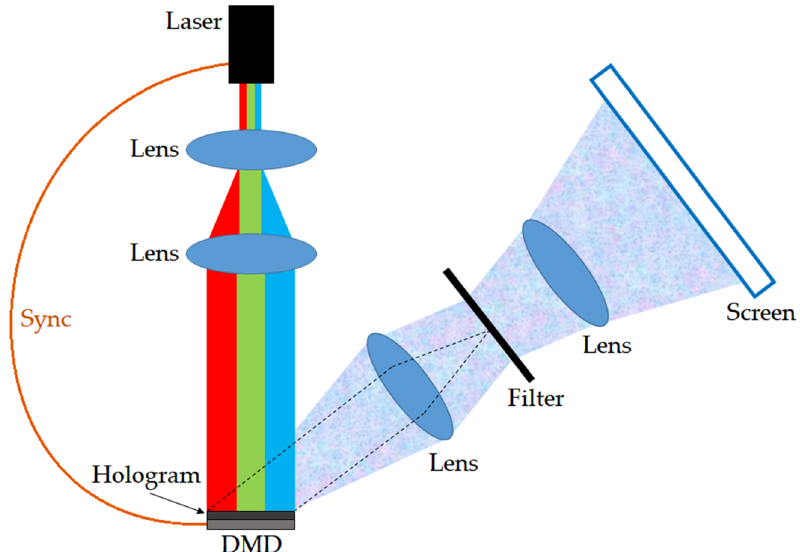
Figure 5. Optical system using a DMD.